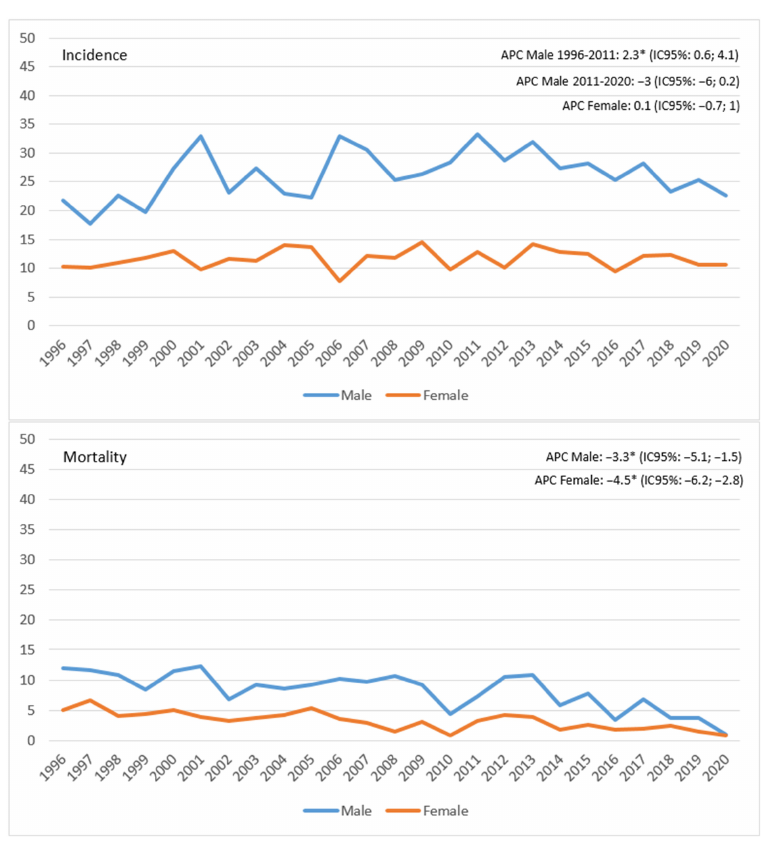
Figure 1. Reggio Emilia Cancer Registry. Years 1996–2020. Age-standardized incidence and mortality rates per 100,000 p-y in the province of Reggio Emilia. APC: annual percent change * APC is significantly different from zero at the α = 0.05 level.